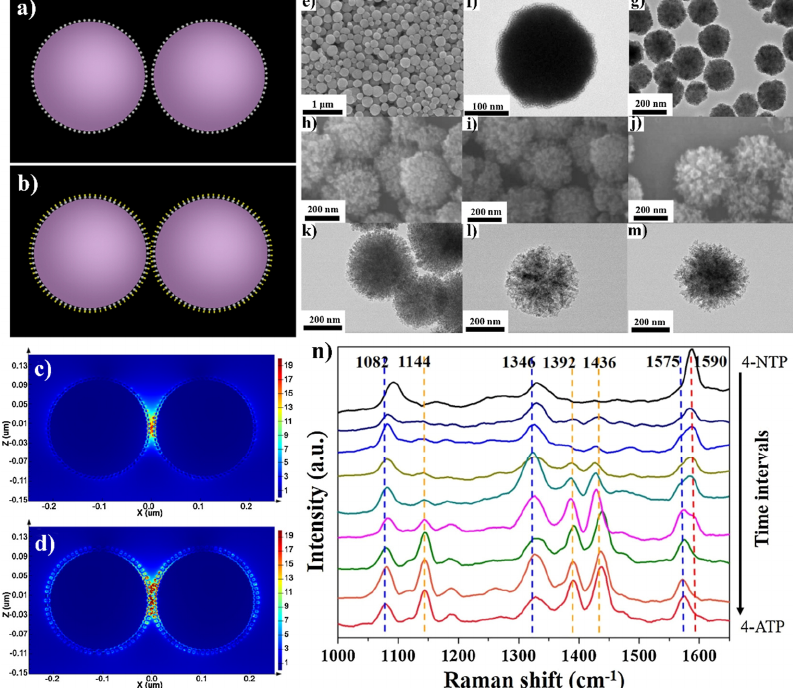
Figure 10. ( a ) The simulation model of Fe 3 O 4 @TiO 2 @Ag and ( b ) Fe 3 O 4 @TiO 2 @AuAg nanoparticles, ( c ) the calculated electromagnetic field distribution around Fe 3 O 4 @TiO 2 @Ag and ( d ) Fe 3 O 4 @TiO 2 @AuAg nanoparticles. The incident light wavelength was 785 nm. ( e ) SEM images of Fe 3 O 4 spheres, ( f ) TEM image of Fe 3 O 4 @TiO 2 core–shell sphere, ( g ) SEM images of Fe 3 O 4 @TiO 2 @Ag sphere, ( h – j ) SEM images of Fe 3 O 4 @TiO 2 @AuAg nanospheres with various molar ratio of Ag:Au: ( h ) 1:2,